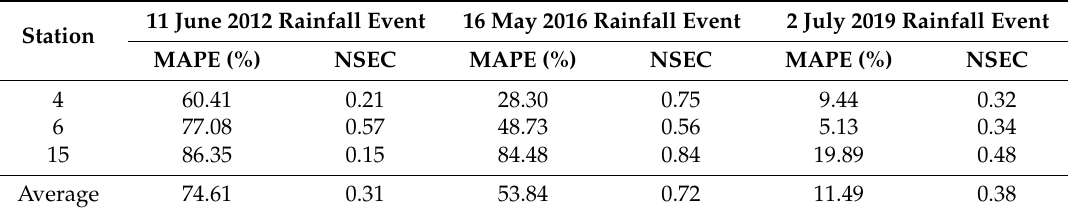
Table 3. AI platform and Mean Absolute Percentage Error (MAPE) and Nash Sutcli ff e E ffi ciency Coe ffi cient (NSEC) performance